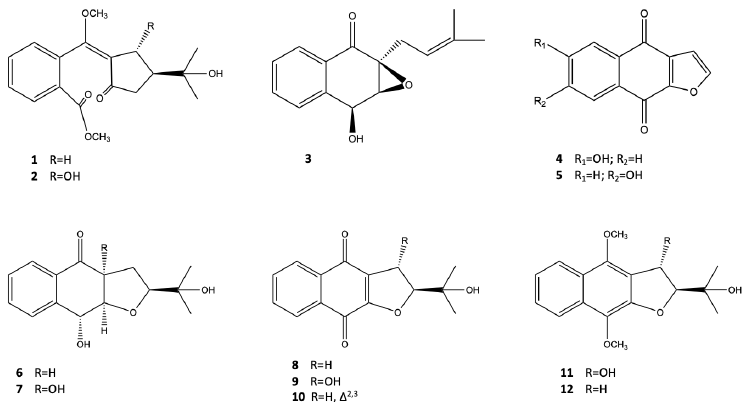
Figure 2. Naphthalene derivatives from A.